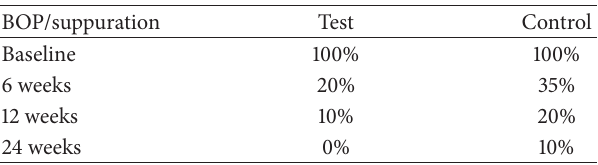
Table 3: BOP and suppuration values in test and control group after 6, 12, and 24